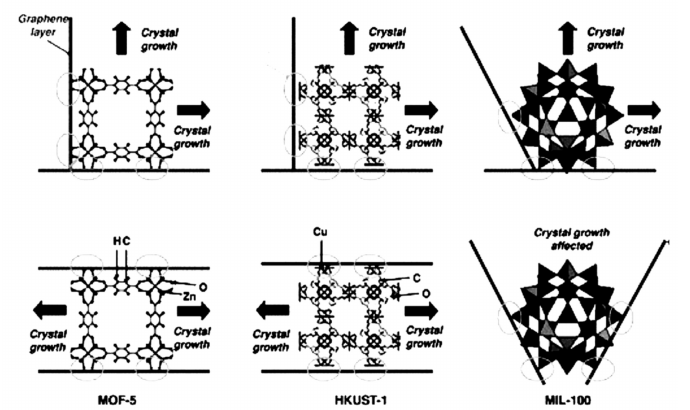
Figure 13. Schematic of the crystal growth of MOF-5, HKUST-1, and MIL-100 on GO layers. Reprinted with permission from